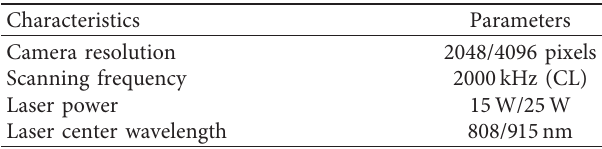
Table1: LQ-H3X module parameters. Table 2: Hyperparameter configuration.